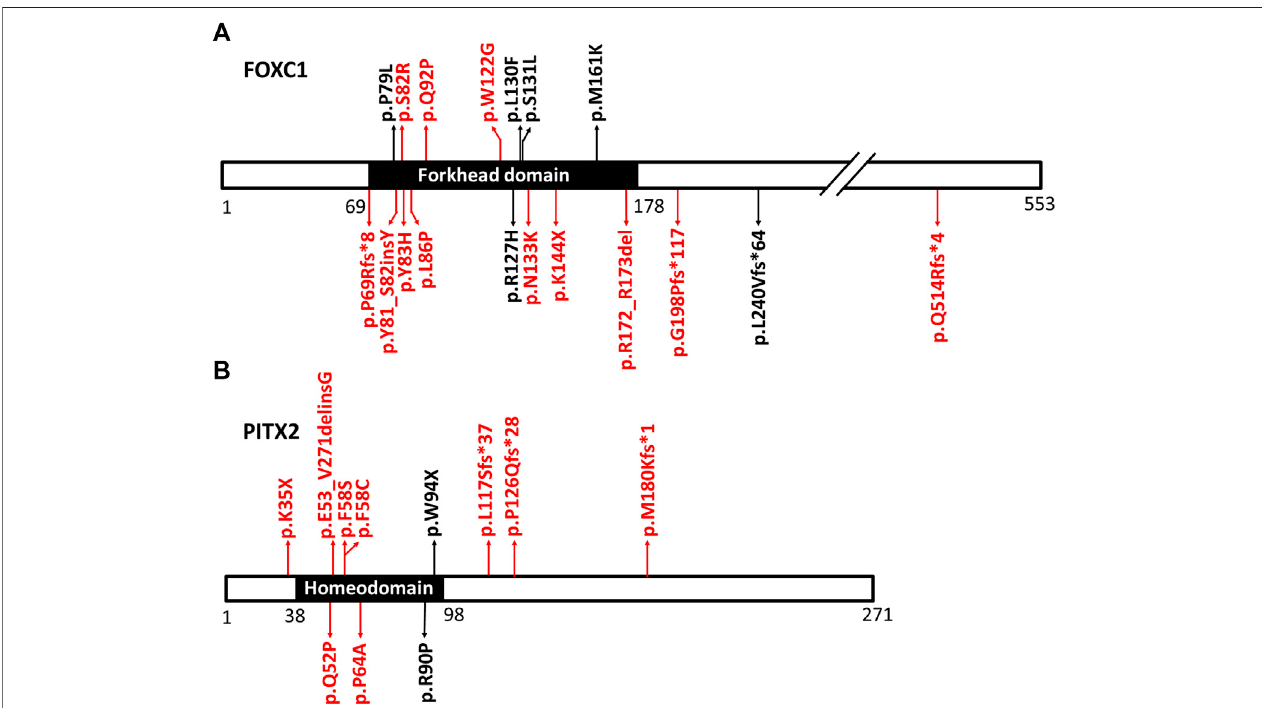
FIGURE1| ThepositionsofthedetectedvariantsinFOXC1andPITX2. (A) isthediagramofFOXC1proteinanditsvariants. (B) isthediagramofPITX2proteinand its variants. The main function domains (forkhead domain in FOXC1 protein and homeodomain in PITX2 protein) are shown in black. The positions of the variants in FOXC1 and PITX2 are indicated by arrows. The novel variants are shown in red. Gross deletions spanning FOXC1 and splicing variants in PITX2 were not shown in Figure 1